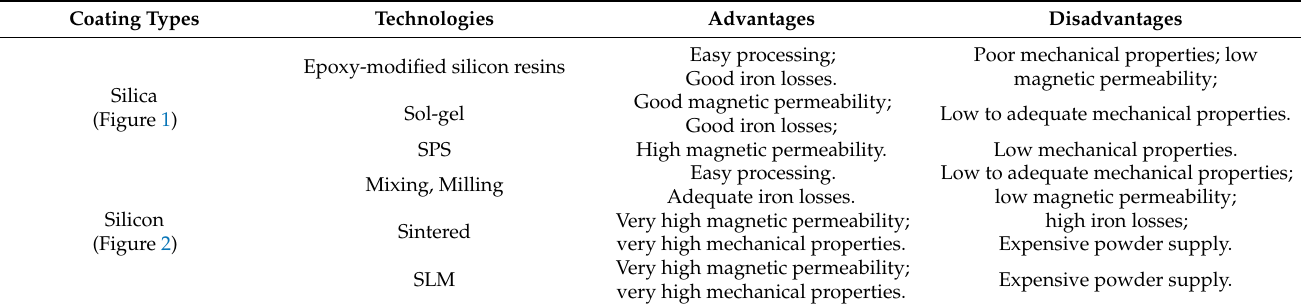
Table 1. Advantages and disadvantages in adoption of various inorganic